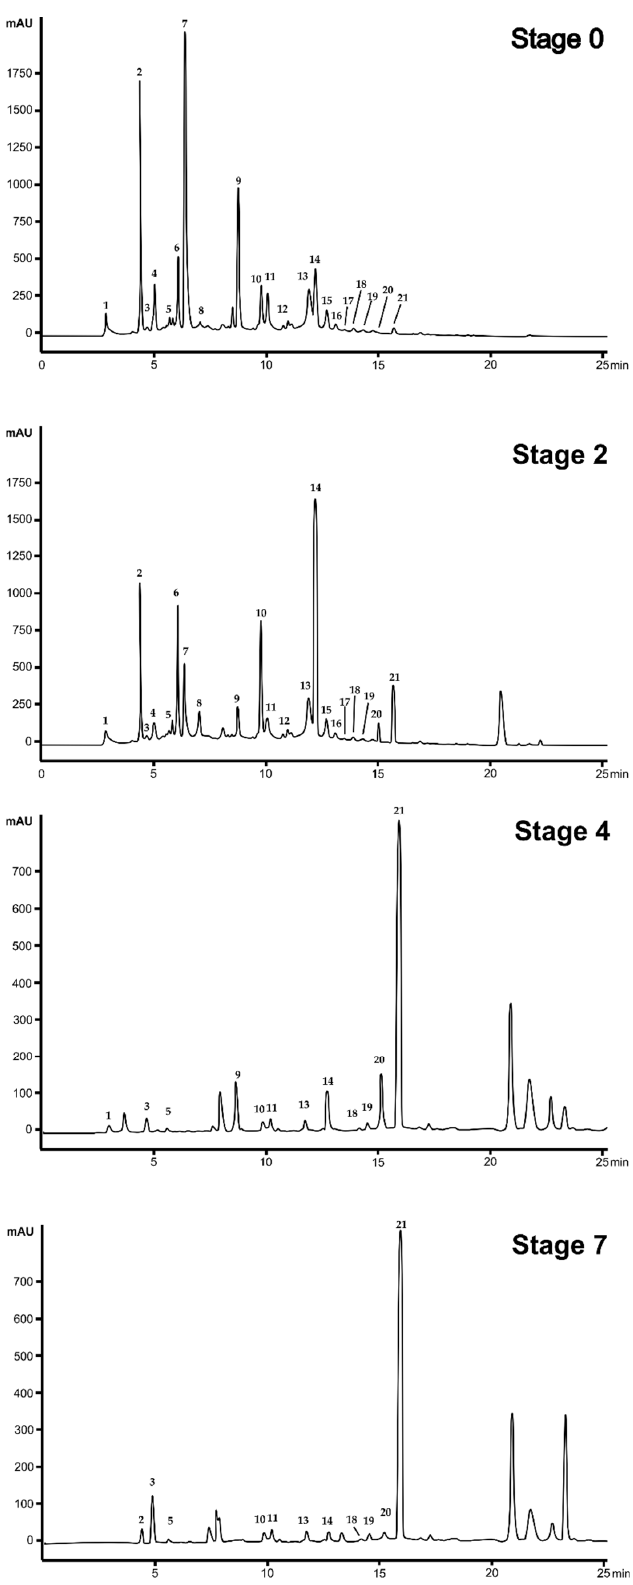
Figure 4. Representative chromatograms of Cellina di Nardò olive extracts during the maturation process. Detection at 280 nm. For the identification of the peaks and relative compounds, see Table 1.